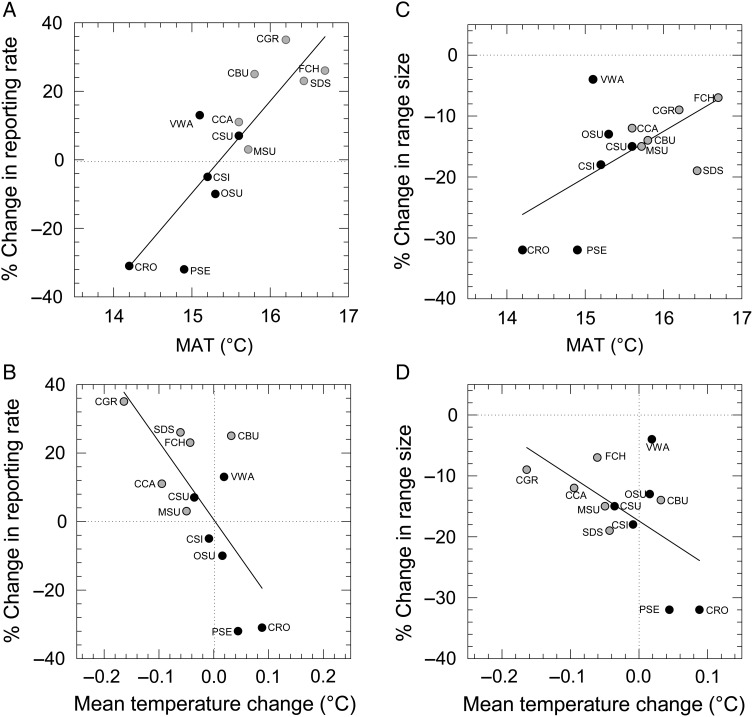
(A,B) There was a significant correlation between change in reporting rates of Fynbos resident bird species between SABAP1 and SABAP2 and mean annual temperature of each species' range (MAT, A). In addition, there was also a significant correlation between changes in reporting rates and change in temperature within each species' range between SABAP1 and SABAP2 (B). (C,D) There were also significant correlations between the degree of range contraction of Fynbos resident bird species between SABAP1 and SABAP2 and mean annual temperature of each species' range (MAT; C), and change in temperature within each species' range between the two survey periods (D). Black circles represent Fynbos endemics and grey circles represent non-endemics. Each species' data point is labelled with a three-letter acronym, as follows: CBU, Cape bunting; CCA, Cape canary; CGR, Cape grassbird; CRO, Cape rockjumper; CSI, Cape siskin; CSU, Cape sugarbird; FCH, familiar chat; MSU, malachite sunbird; OSU, Orange-breasted sunbird; PSE, Protea seedeater; SDS, Southern double-collared sunbird; VWA, Victorin's warbler.